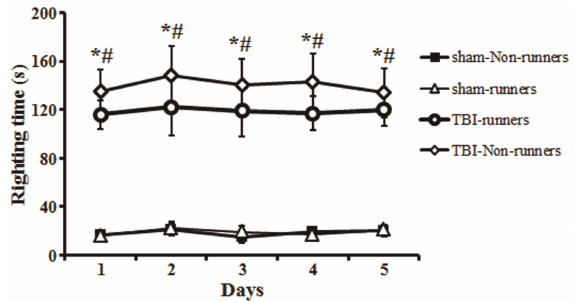
Figure 3. miRNA analysis of samples from the four groups. The heat-map shows the significant differentially expressed miRNAs. miRNA expression in paired non-runners (NR) from sham-non- runners and traumatic brain injury (TBI)-non-runners, sham- operated mice from sham-non-runners and sham-runners (R), as well as TBI mice from TBI-non-runners and TBI-runners were profiled. Red and green color scales represent high and low expression,